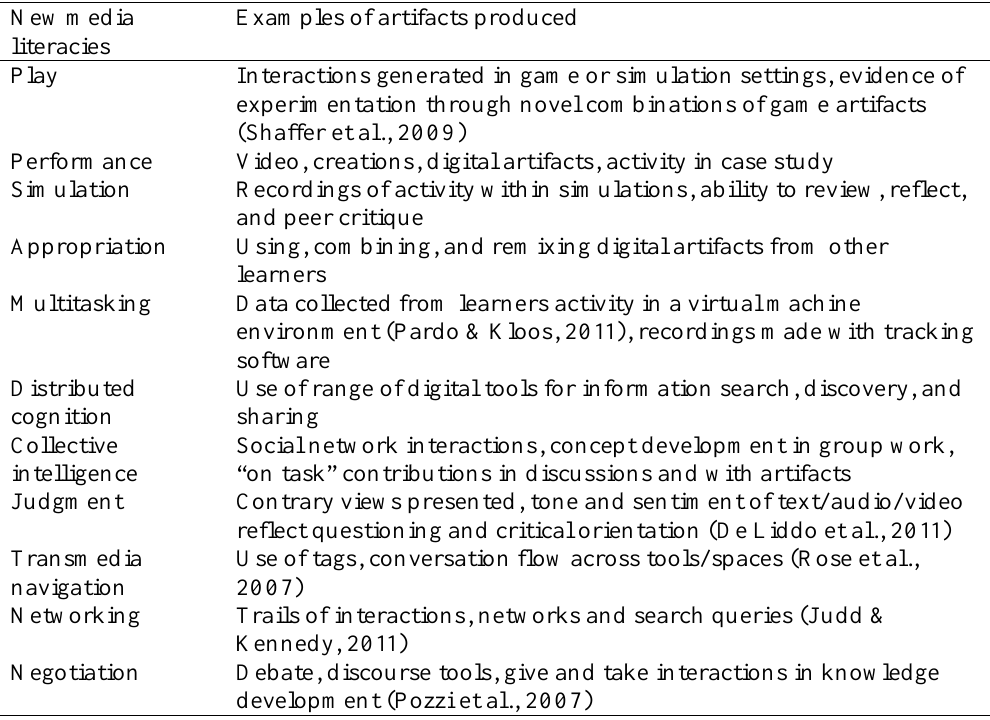
Table 2 Artifacts Generated for Assessment as Exhibited by Different